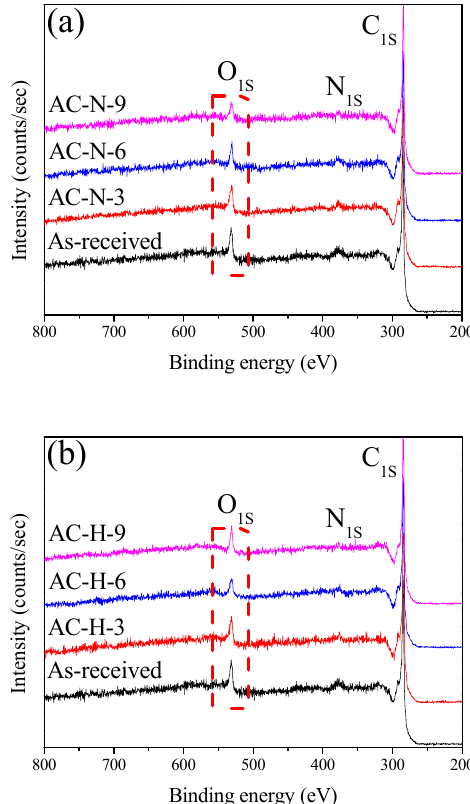
Figure 2. XPS survey spectra of AC heat-treated under different conditions; ( a ) AC-N, ( b ) AC-H. Substantial changes in OFGs due to pyrolysis or reduction can be identified by examining the O 1 s core region. As shown in Figures 3 and 4, to determine the OFGs on the surface of the AC, the O 1 s spectra were curve-fitted into four individual peaks: C=O in carbonyl and quinone (O1, 531.3 eV); C-OH in phenol, C-O in ether, and C=O in anhydride (O2, 532.3 eV); C-O-C in anhydride (O3, 533.3 eV); and carboxylic acid (O4, 534.7 eV)